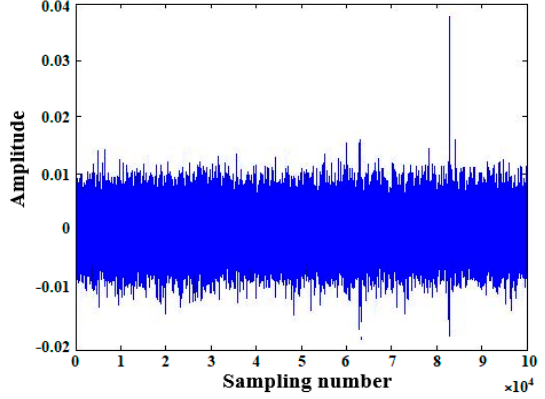
Figure 4. Underwater acoustic signals with a signals-to-noise ratio of 10 dB.